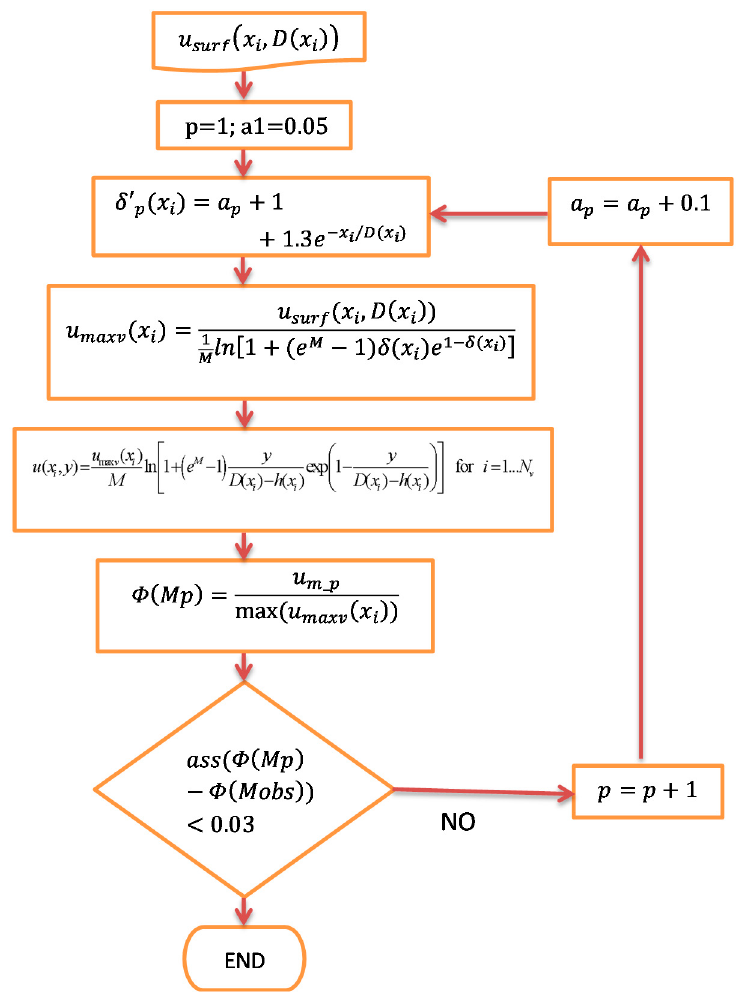
Figure 1. Schematic representation of dip estimation procedure using measured surface velocity, u surf (for symbols see text).